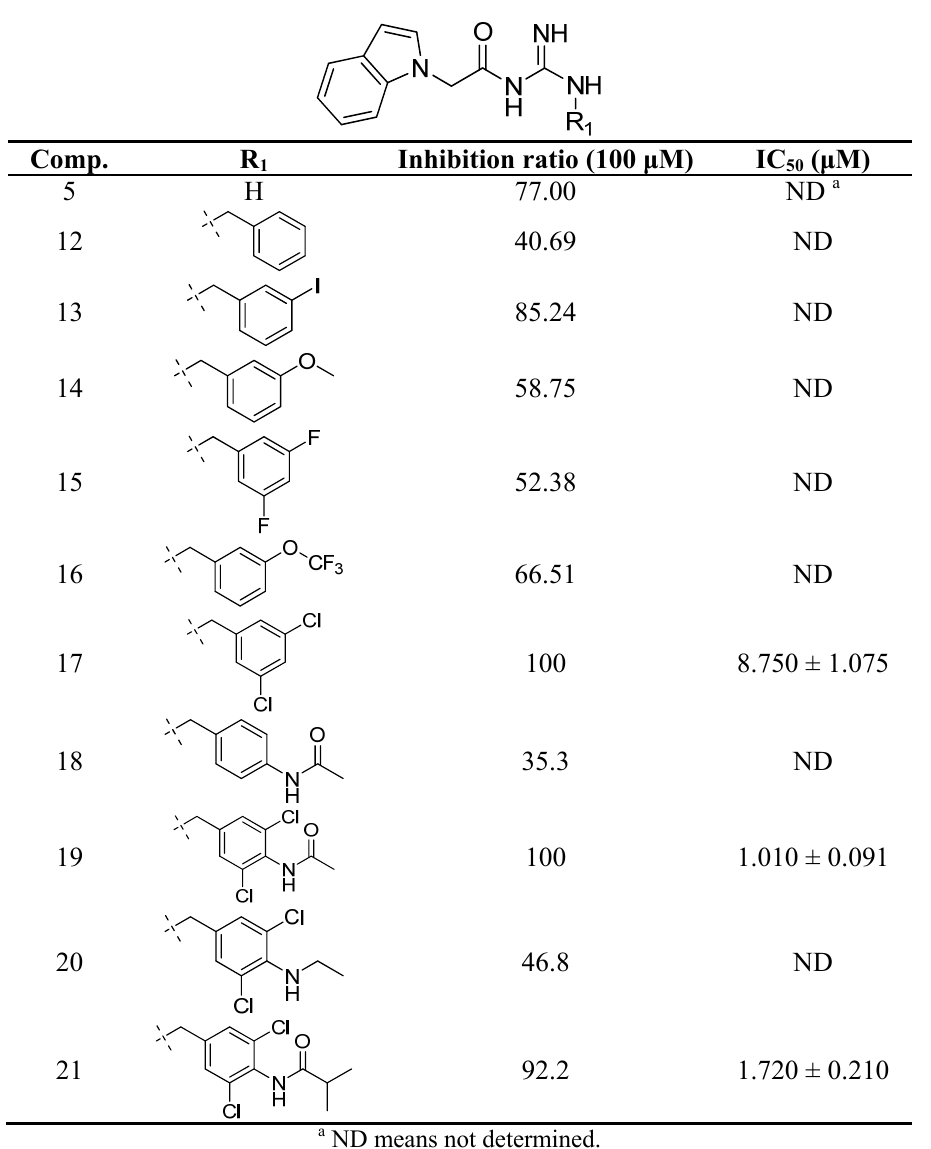
Table 1. BACE1 inhibitory activities of compounds 12 – 21